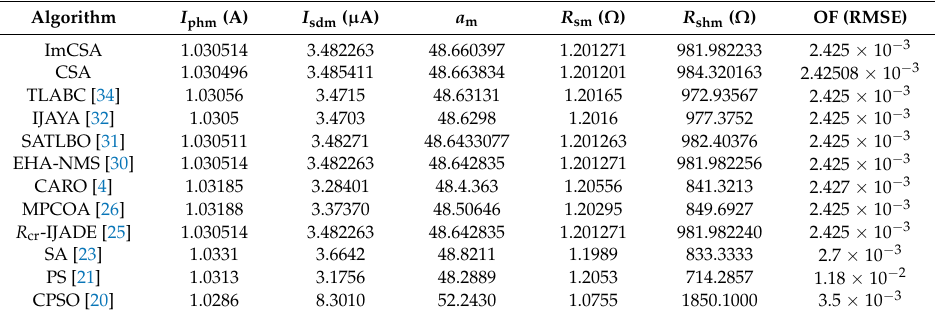
Comparison among various parameter estimation algorithms for the PMM of Photowatt-PWP201